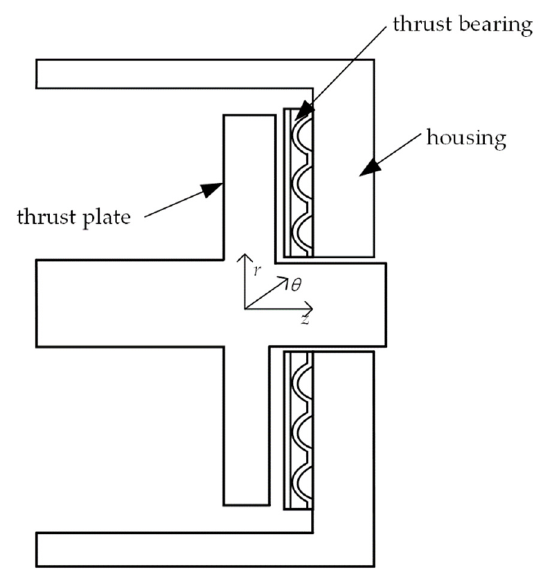
Figure 6. Single side gas thrust bearing configuration.